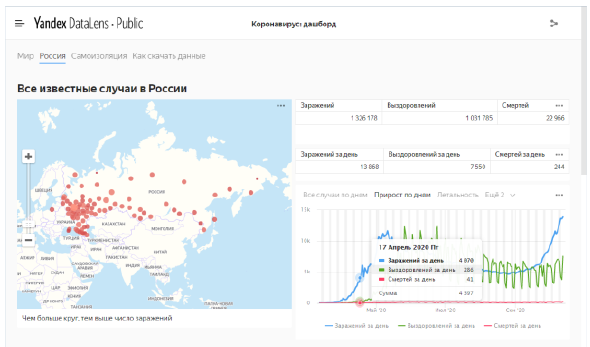
Figure 4. Web interface of the COVID-19 dashboard from the